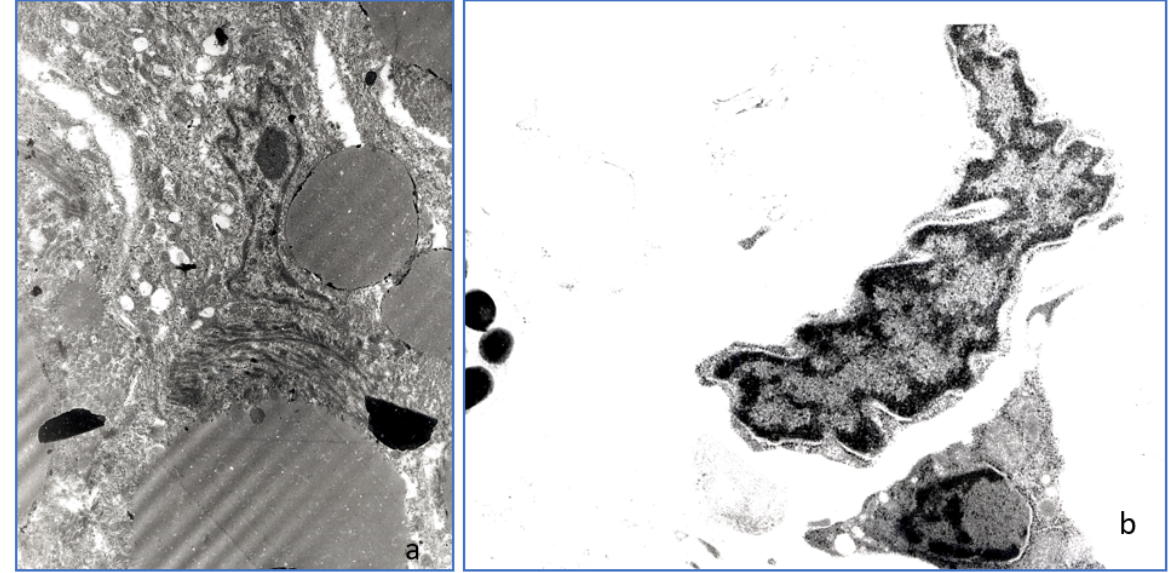
Figure 6. ( a , b ) Tumor n. 6 (SPINDLE CELL LIPOMA). ( a ) Lipoblasts with intracytoplasmatic lipidic droplets of various size (12,000×), ( b ) Spindle cells: the nucleus presents folded and corrugate profile (8700×).